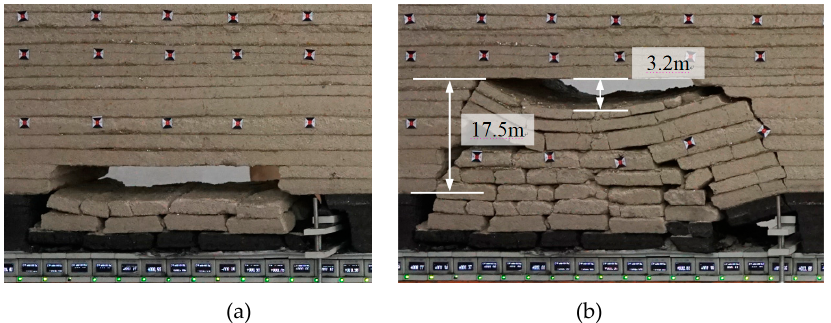
Figure 21. Roof caving: (a) advanced to 42m; (b) advanced to 56m.